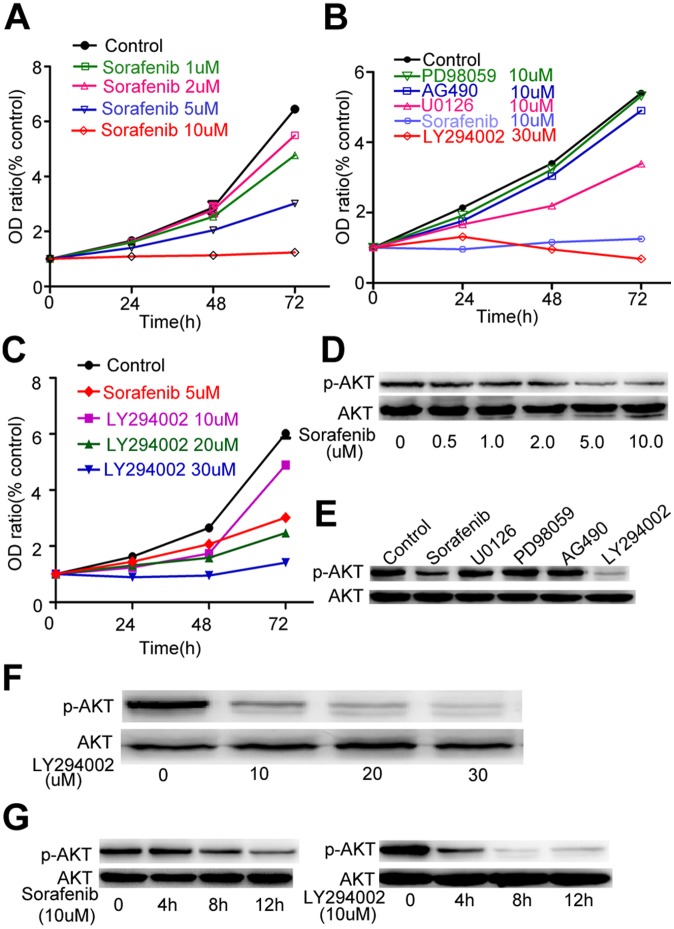
Sorafenib inhibited proliferation of NK-92MI cells mainly by blocking the PI3K/AKT pathway.(A) Sorafenib inhibited proliferation of NK-92MI cells dose-dependently. (B) Addition of different specific inhibitors had different effects on the proliferation of NK-92MI cells at the indicated time. (C) Different concentrations of LY294002 had an inhibitory effect on proliferation of NK-92MI cells at the indicated time. (D, E) Cells were treated with different concentrations of Sorafenib and LY294002 for 6 h. (F) Cells were treated with different inhibitors (10 µM) for 6 h. (G) Cells were treated with sorafenib (10 µM) and LY294002 (10 µM) for different lengths of time.